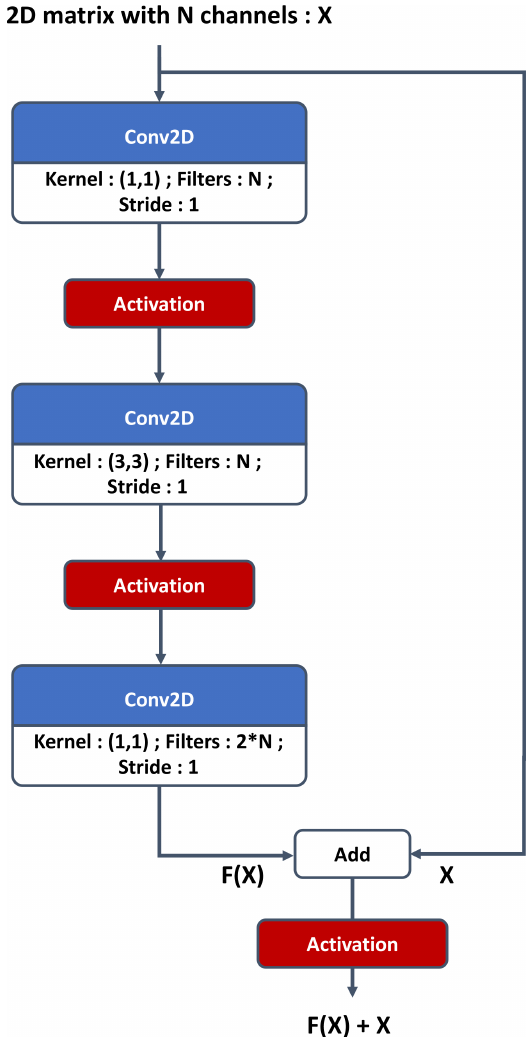
Figure 2. Residual identity block for the critic.